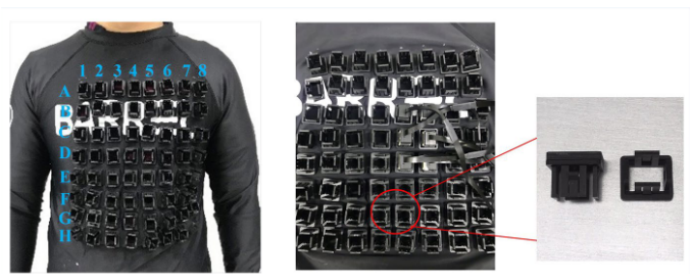
Figure 15. Position labels of the 8 × 8 array with 30 mm intervals, QZFM magnetometer and customized receptacles [127].